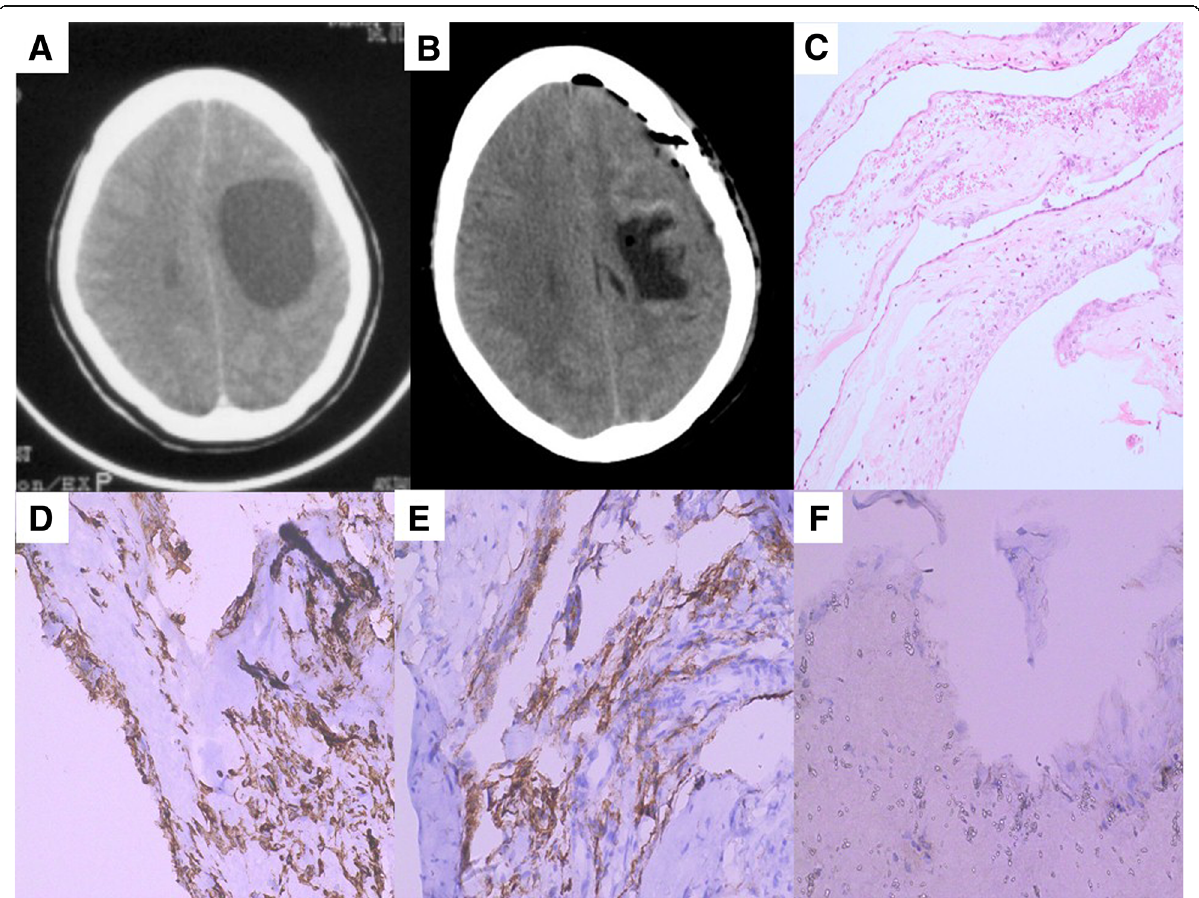
Fig. 2 a Preoperative CT head (axial) shows hypodense lesion at the left posterior frontal area. b Post-op CT (axial) head shows excision of the cyst. c Histopathology revealed fibro collagenous cyst wall lined by flat to low cuboidal arachnoidal cells of single cell thickness suggestive of an arachnoid cyst. d Positive for vimentin. e Positive with epithelial membrane antigen (EMA) stain. f Slide was negative for glial fibrillary acidic protein